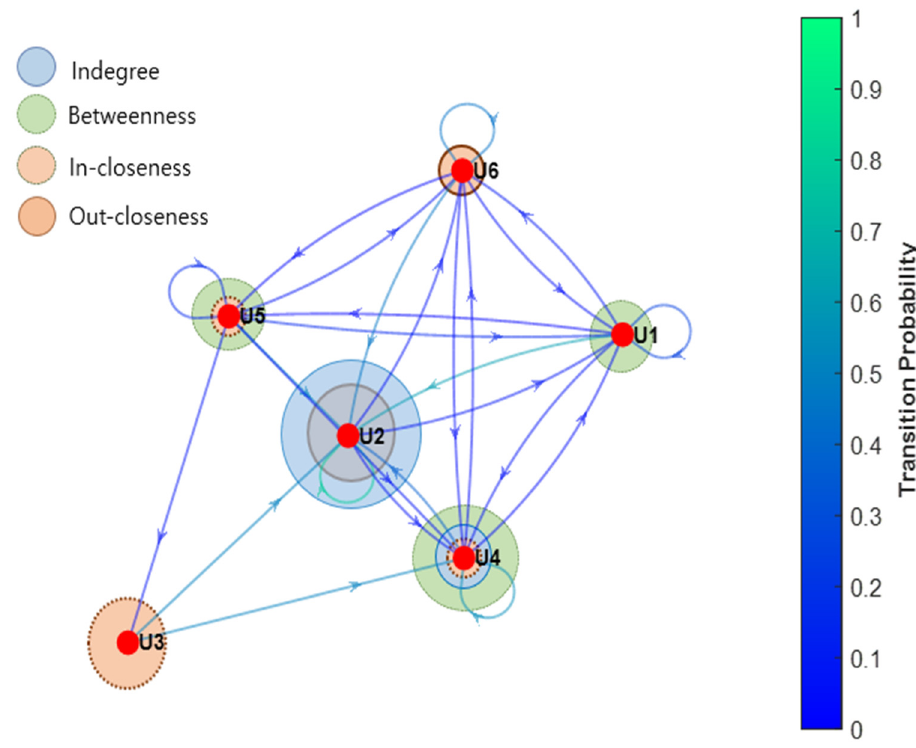
Figure 3. Network of visiting states in the movements of wild boar individuals in different habitats. The red dots indicate nodes (i.e., habitats; Table 1) in the network while arrows represent edges connecting the nodes, showing the direction of transition (i.e., wild boar movement) between nodes in network. The size of shaded circles presents the intensity of centrality.